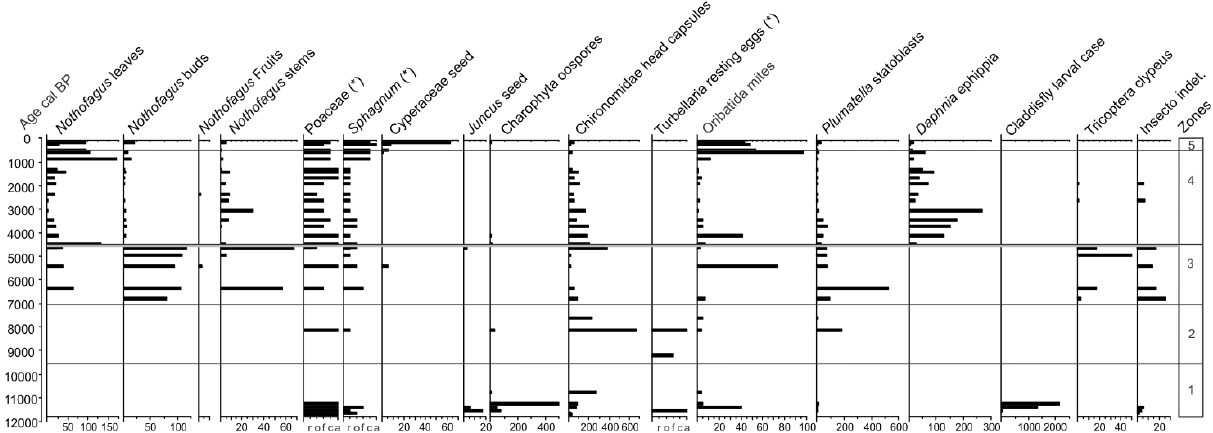
Figure 5. Península Avellaneda Alto (PAA) macrofossil diagram, expressed in terms of concentration (remains per 10 cm 3 ), or (*) relative abundance (r = rare, o = occasional, f = frequent, c = common, a = abundant). The grey line at 4500–4600 cal yr BP represents the tephra